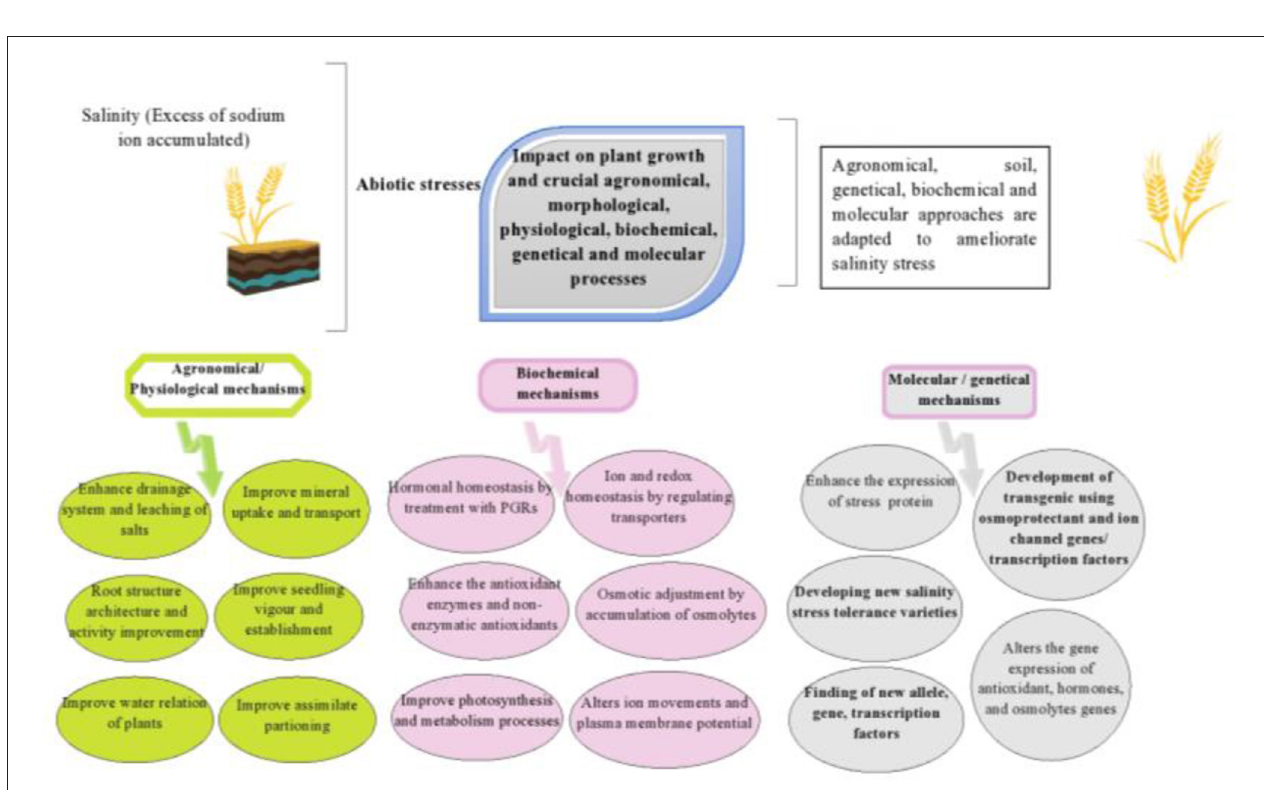
FIGURE 3 | Illustrate the integrated approaches (physiological, biochemical and molecular) of salinity stress tolerance in wheat crop.